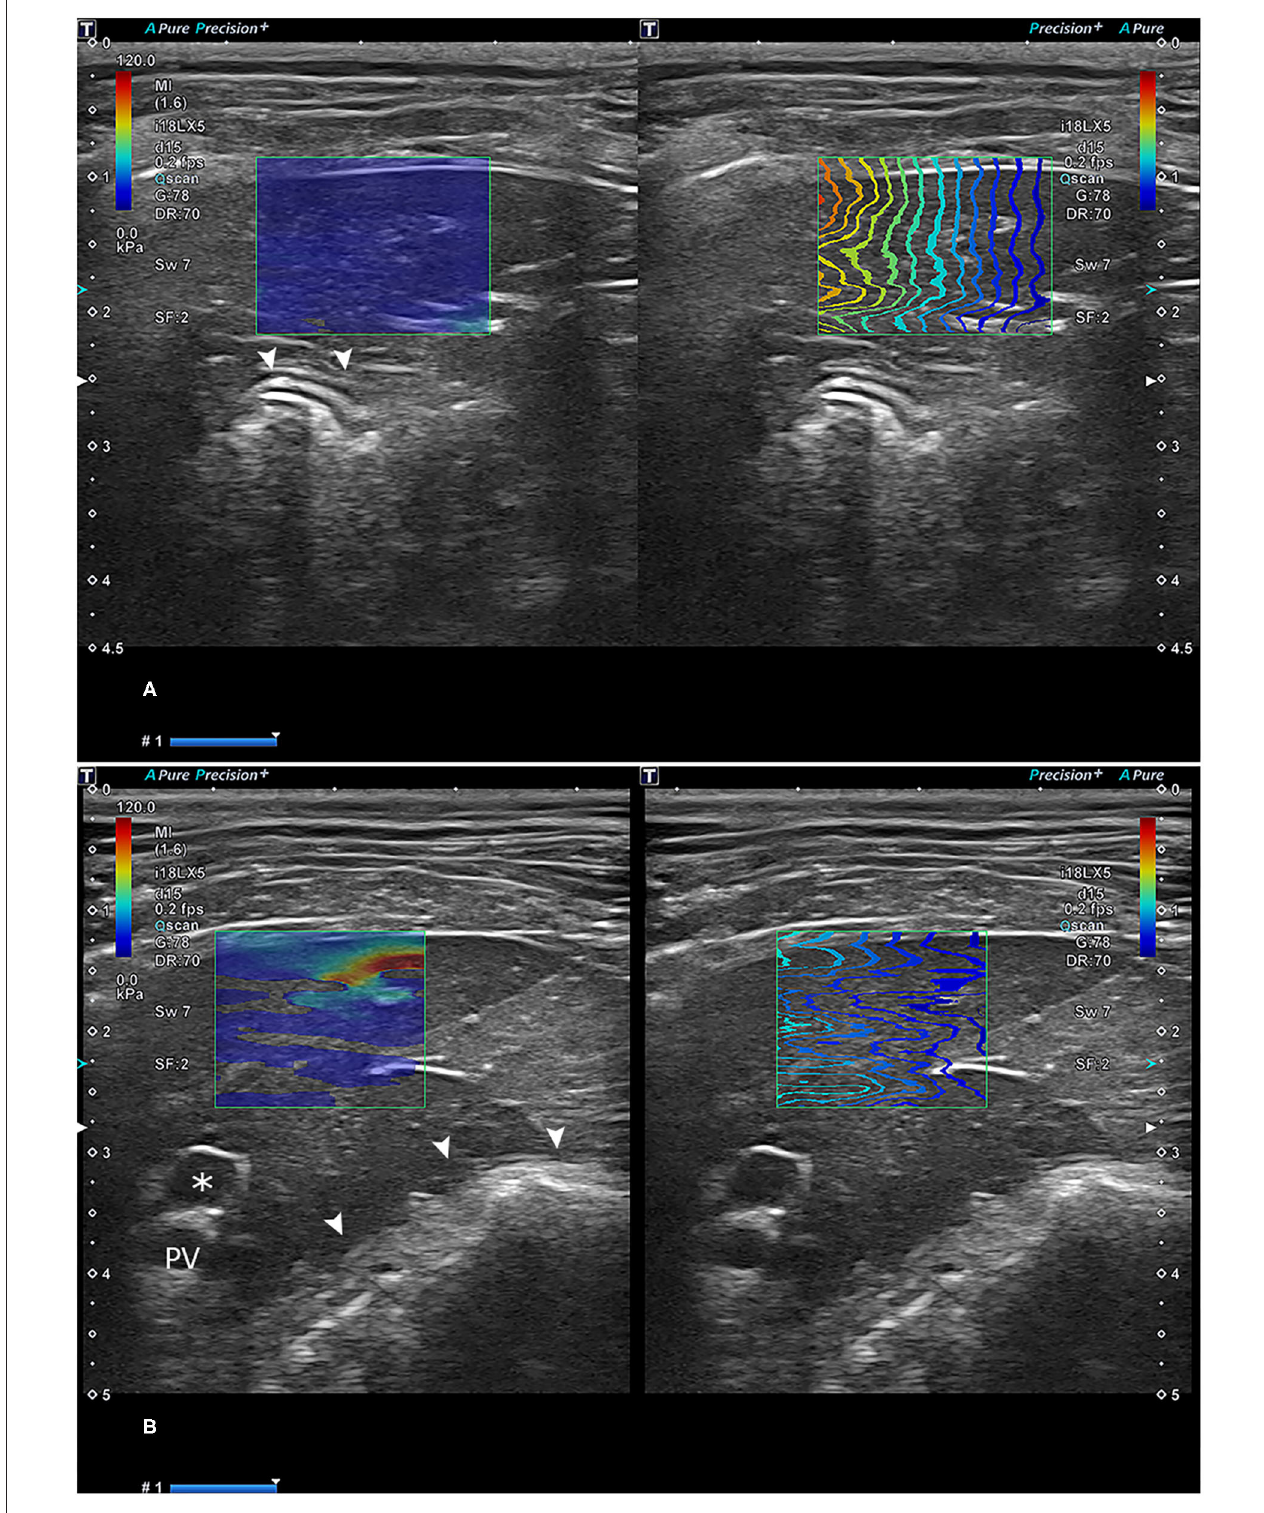
FIGURE 2 | Reliable (A) and unreliable (B) two-dimensional shear-wave elastography images. In (A) , the propagation lines are linear and parallel to each other. In (B) , lines are not linear, with some unconnected parts with a lack of parallel appearance. Asterisk: gallbladder; arrowhead: stomach. PV, portal vein.